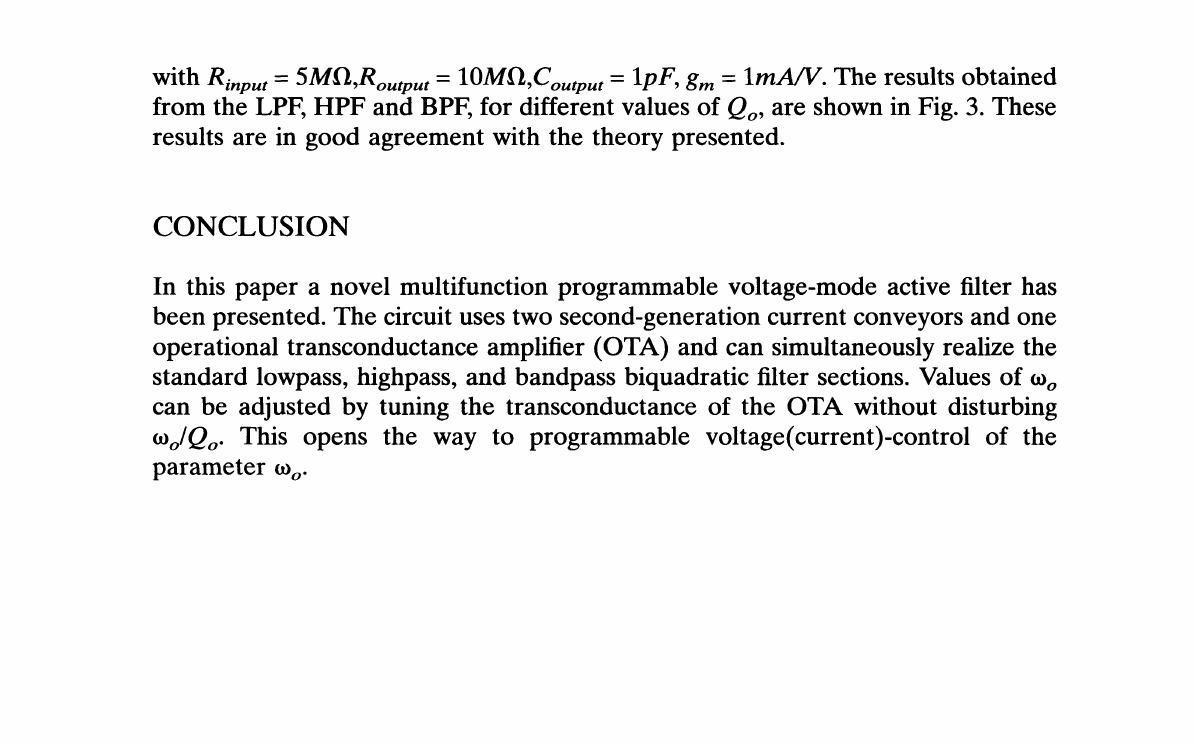
FIGURE 2 (a) Nonideal model for the current conveyor CCII+ and (b) Nonideal model for the OTA.